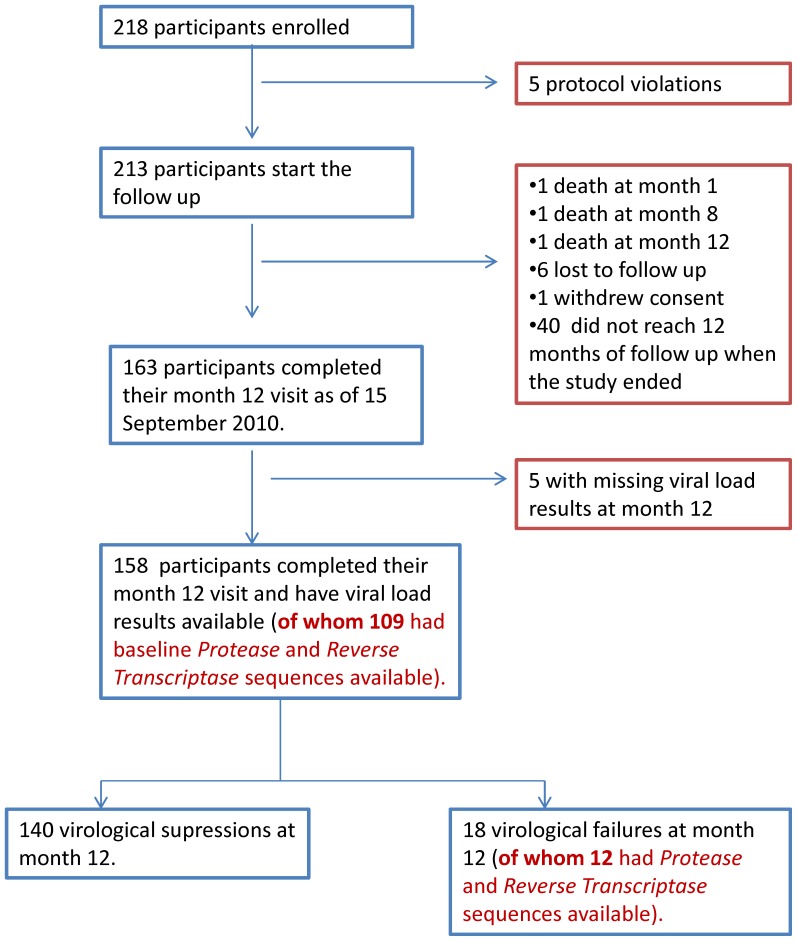
Study profile.Of the 218 were enrolled in the study, 213 started the 12 month follow-up. One hundred and fifty-eight participants completed their month 12 visit and had viral load results available at baseline and month 12. Of these 140 could be classified as virological successes (VL≤1000 copies/mL) and 18 as virological failures (VL>1000copies/mL).